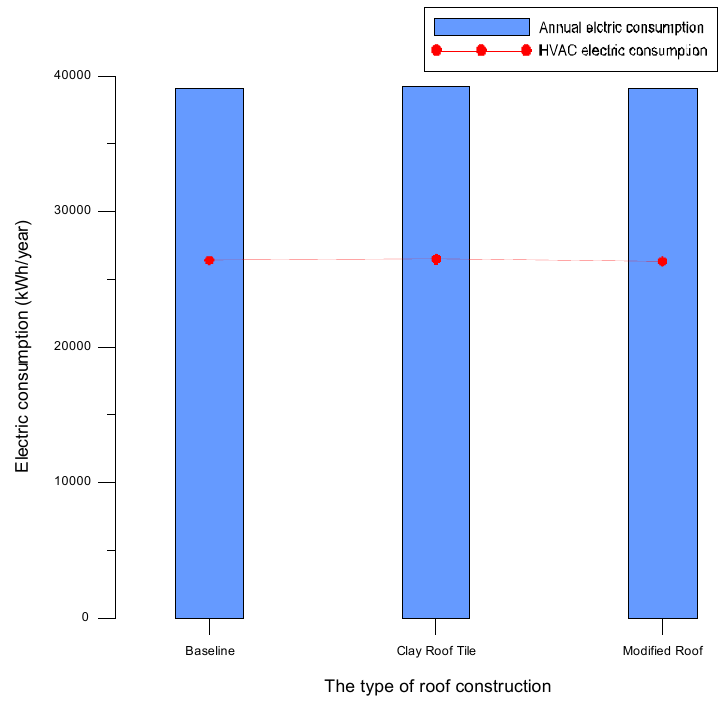
Figure 6. Comparison of the annual energy consumption densities for different roof